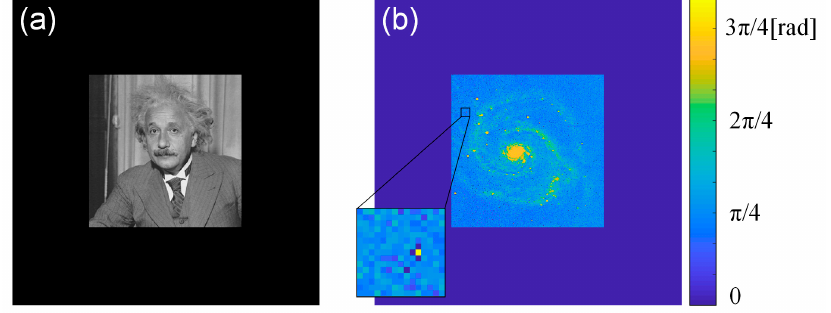
Figure 4. The complex amplitude of the simulated object: ( a ) the amplitude; ( b ) the phase.